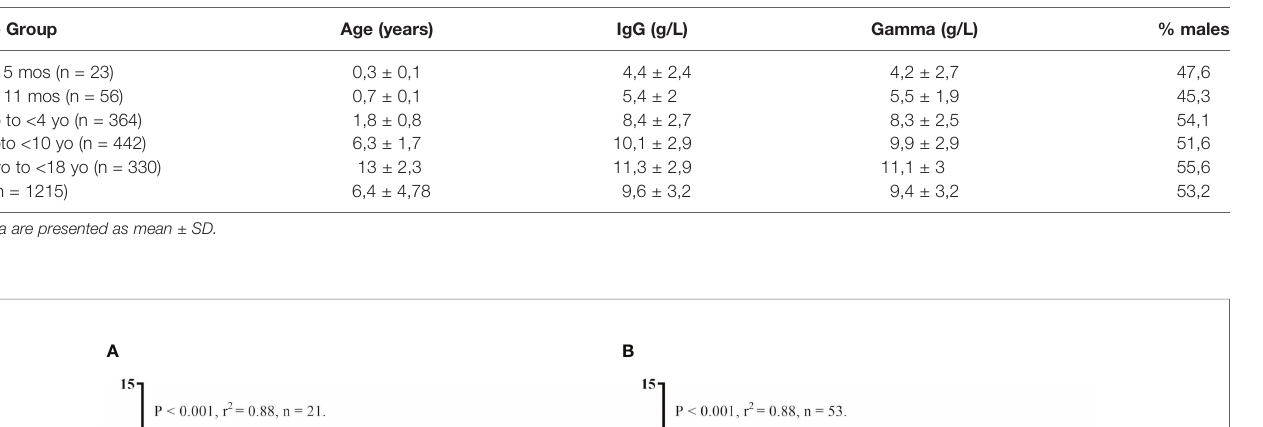
TABLE 3 | Characteristics of patients studied for the IgG vs Gamma fraction correlation a .